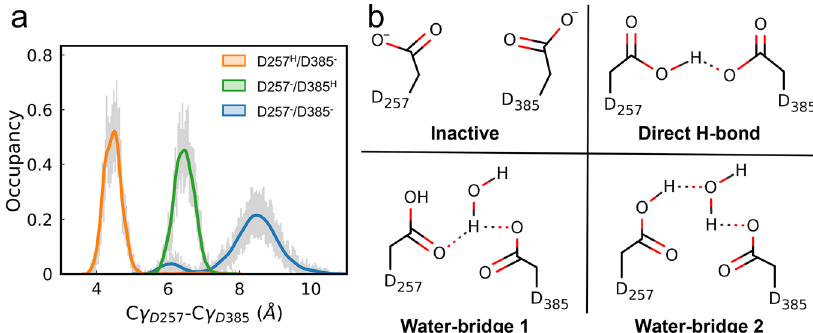
Fig. 4 The activation of catalytic core is dependent on the protonated states of D257 and D385. a The distribution of the C γ -C γ distance between catalytic sites D257 and D385 in unbiased MD simulations. Uncertainty is estimated with histogram analysis. b The stable con fi gurations of D257/D385 are identi fi ed according to the C γ – C γ distance, including an inactive unprotonated state and three monoprotonated states where the side chains of the two aspartic acid residues are either directly hydrogen-bonded or